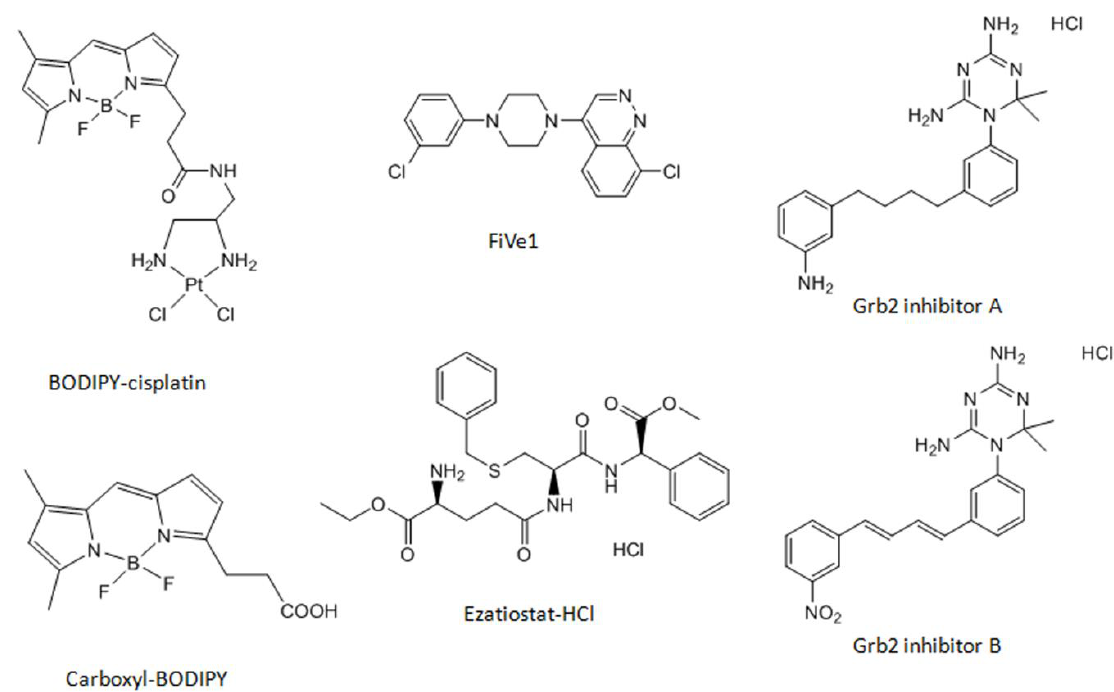
Figure 1. ChemicalstructuresofthecisplatinanalogBODIPY-cisplatin,platinum-freelabelcarboxyl-BODIPY, Figure 1. Chemical structures of the cisplatin analog BODIPY-cisplatin, platinum-free label and the inhibitors used in this carboxyl-BODIPY, and the inhibitors used in this study. Table 1. Cytotoxicity (pEC 50 , mean ± SEM, n = 5–8) of cisplatin, oxaliplatin, BODIPY-cisplatin, and carboxyl-BODIPY in A2780, A2780cis, HCT-8, and HCT-8ox cells (the respective EC 50 values are given in parentheses).